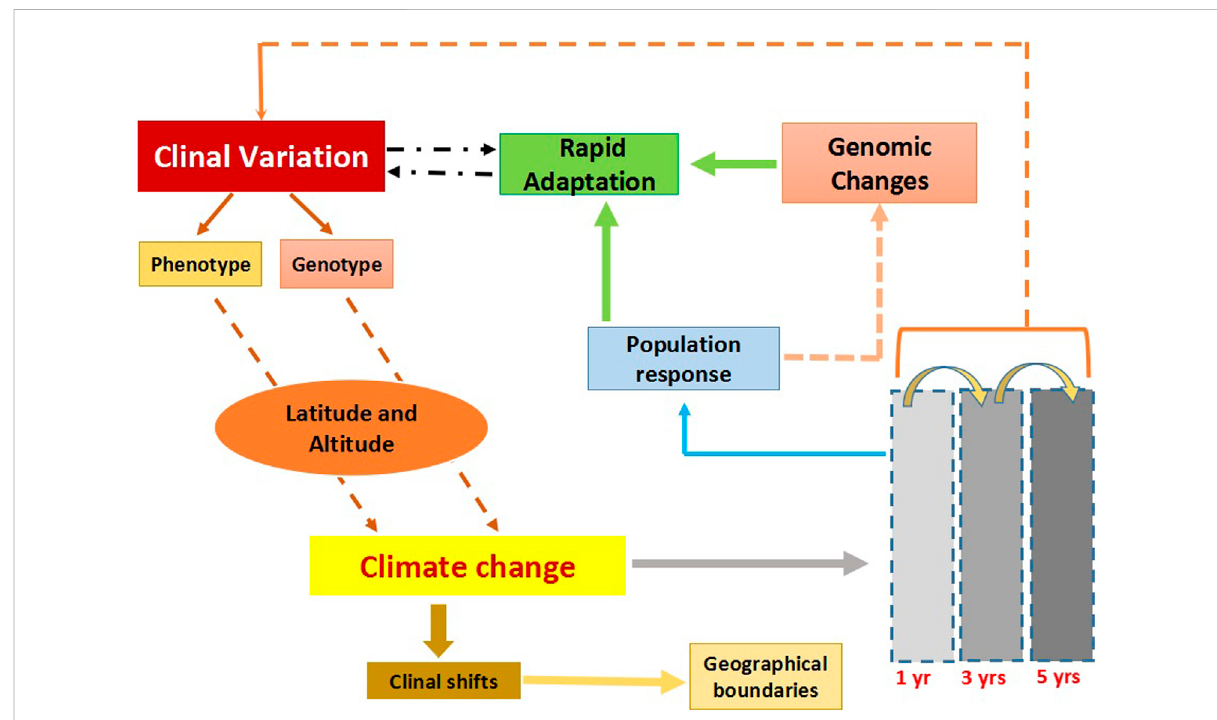
FIGURE 1 The fl owchart describes clinal variation and the impact of climate change on clines. Clinal variation can occur both at the phenotypic and genotypic level across different geographic scales; altitude and latitude. Climate changes are known to in fl uence existing clines, resulting in clinal shiftsinwhich specieseither expandorcontractintheirhabitat range.Response toclimatechangecouldberapidandthese couldbetrackedwithin aspanoffewyears.Populationsrespondingtoclimatechangeatthegenomiclevelcouldmodifyexistingones.Overallclinescouldbeatoolto track rapid environmental